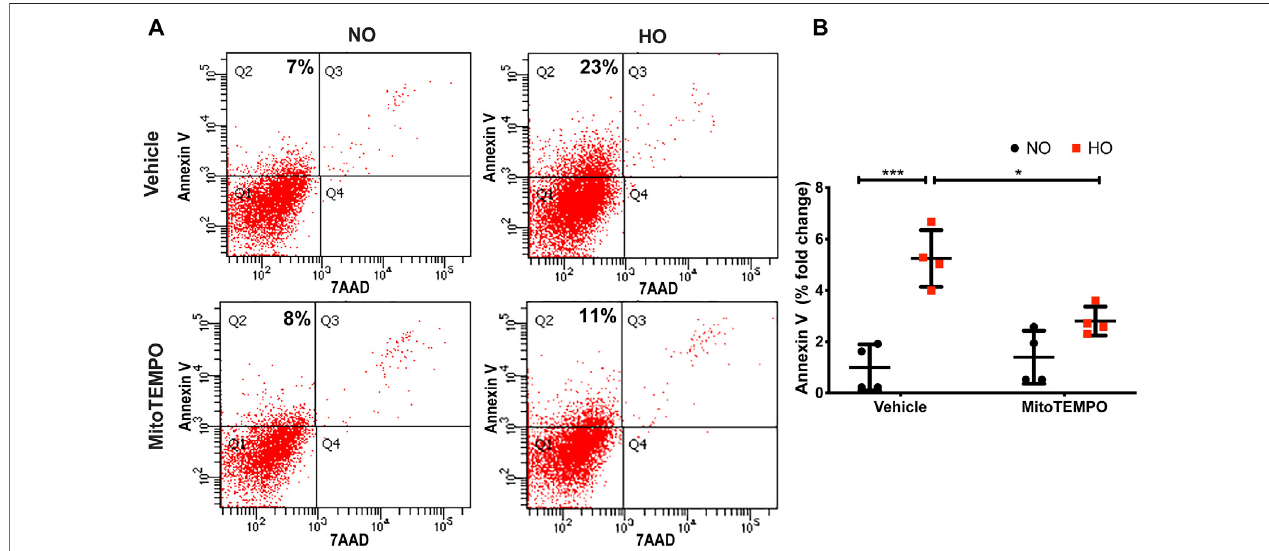
FIGURE 11 | MitoTEMPO attenuates HO-induced apoptosis in MLE-12 cells. MLE-12 cells were pretreated with 10uM MitoTEMPO for 1 h followed by HO for 48 h. The cells were stained with Annexin V and 7-AAD and were subjected to fl ow cytometry. (A) Representative dot plots of cells after staining with Annexin V and 7- AAD (B) Quanti fi cation of the percentage of Annexin V- positive apoptotic cells which is expressed as fold-change showing increased apoptotic cells in HO which is signi fi cantly reduced with MitoTEMPO treatment. n = 4. *** p < 0.001, * p <